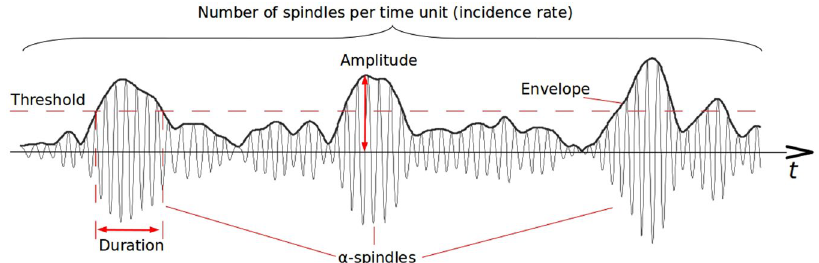
Figure 1. A representative EEG trace filtered in the 8–12 Hz band. Due to the inherent non-stationarity of the EEG time series, the average increase of the alpha-band power can be explained by changes in the duration of alpha spindles, the peak amplitude and the incidence rate of such